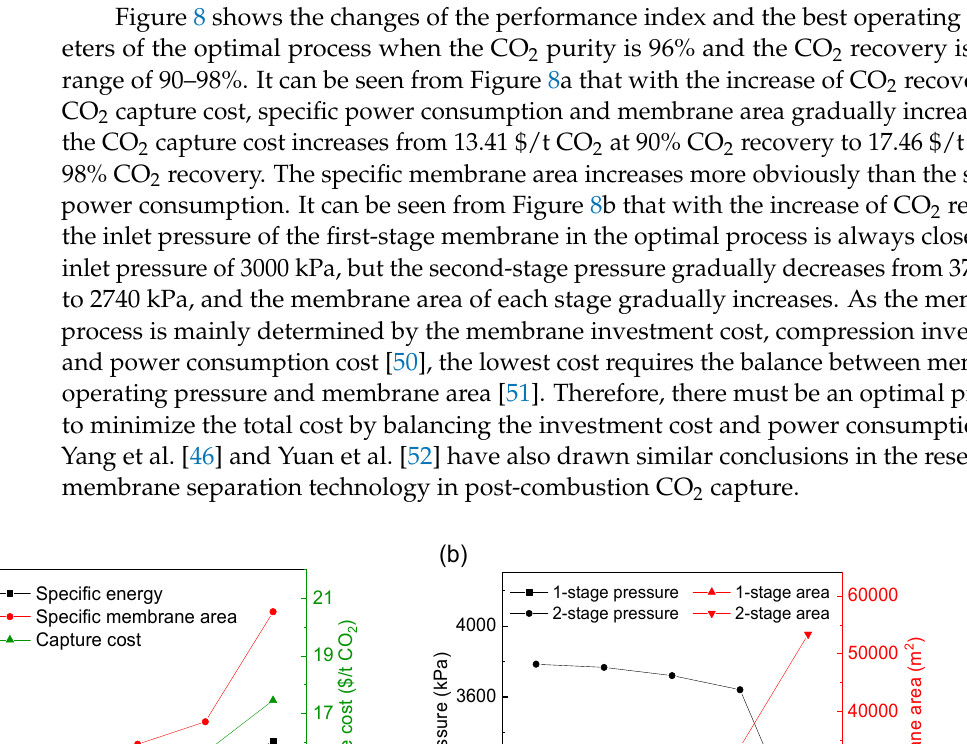
Figure 9. Effect of increasing CO 2 purity on the optimal process using the commercial membrane in Table 2. ( a ) CO 2 capture cost, specific power consumption and membrane area; ( b ) optimal inlet pressure and area of each stage membrane. With the increase of purity, as shown in Figure 9b, the pressure of the first ‐ stage membrane in the optimal process is basically unchanged, but the area of the first ‐ stage membrane increases slightly due to the increase of the recycle flow rate. While the area of the second ‐ stage membrane gradually increases, the inlet pressure of the second ‐ stage membrane gradually decreases. However, because the increase of the second ‐ stage mem ‐ brane area leads to the increase of the recycle flow rate (permeate side of second ‐ stage membrane) in the system, the power consumption of the system still increases gradually. 96